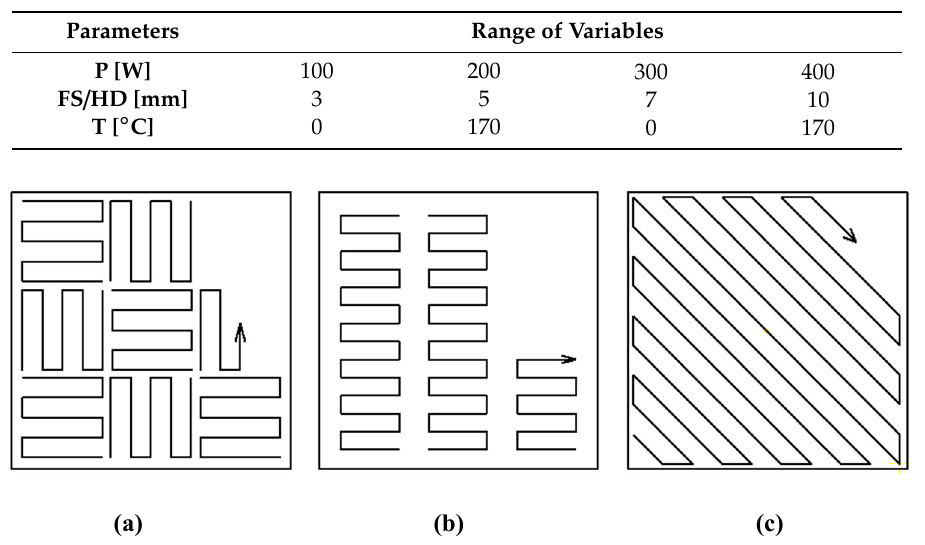
Table 2. Variated parameters for DoE.